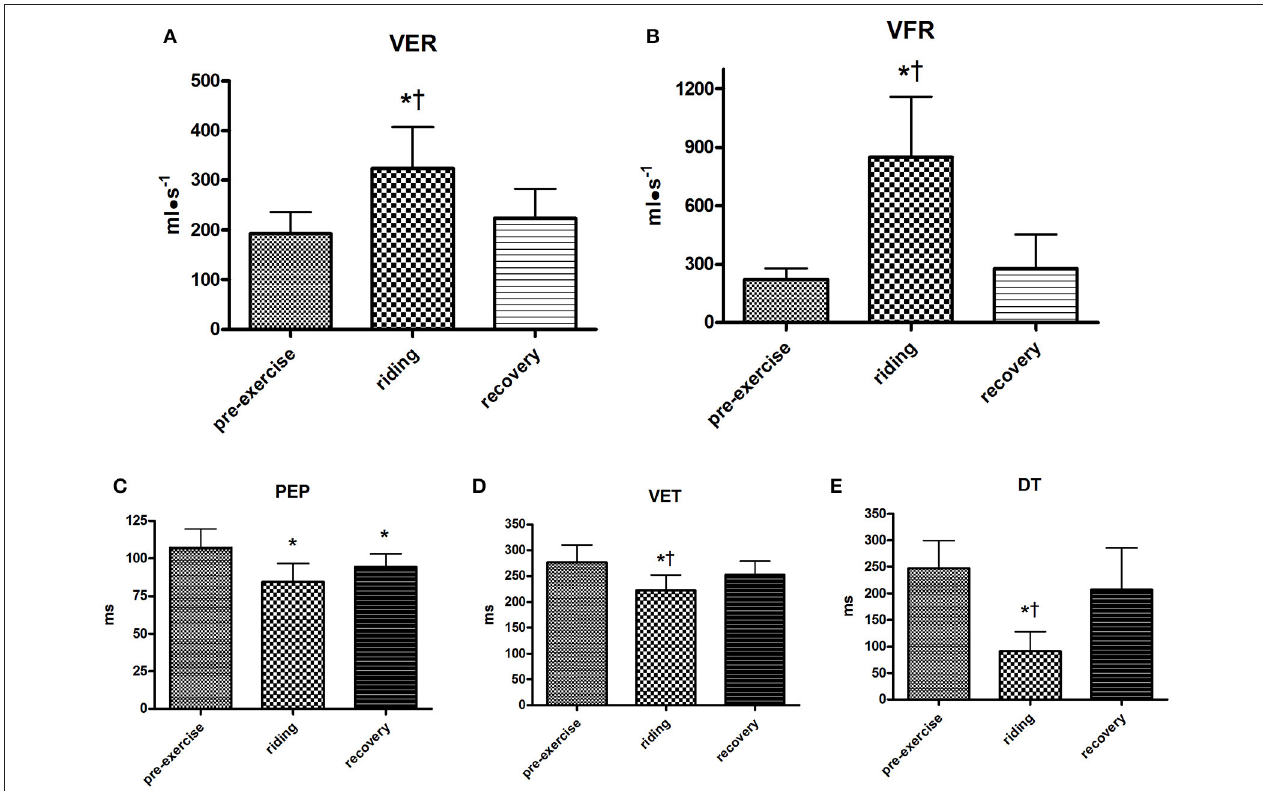
FIGURE 4 | Group ventricular emptying rate (VER, A ), ventricular filling rate (VFR, B ), pre-ejection period (PEP, C ), ventricular ejection time (VET, D ), and diastolic time (DT, E ) during the various periods of the Enduro session. Values are mean ± SD ( n = 15). * p < 0.05 vs. pre-exercise; † p < 0.05 vs.